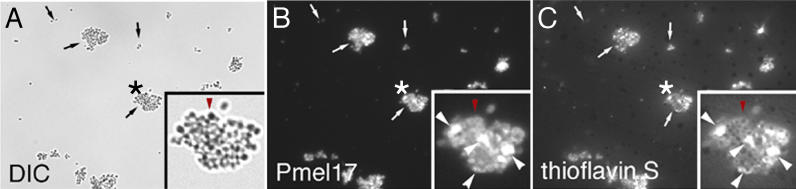
Pmel17 and Thioflavin S Fluorescence Overlap in the Detergent-Insoluble Melanosome FractionA 1% Triton-X 100 detergent-insoluble fraction was prepared from purified melanosomes and visualized using differential interference contrast microscopy (DIC) (A), indirect immunofluorescence using a Pmel17-specific antibody (B), or thioflavin S fluorescence (C). Arrows denote Pmel17-containing insoluble clusters of variable size. Asterisks indicate the enlarged cluster shown in the lower righthand corner of each panel. In the insets, the large white arrowheads denote Pmel17-positive structures (shown in [B]) that directly overlap with thioflavin S staining (shown in [C]); the red arrowhead in (A) denotes a residual dense melanin-containing granule lacking Pmel17 (shown in [B]) that does not stain with thioflavin S (shown in [C]).